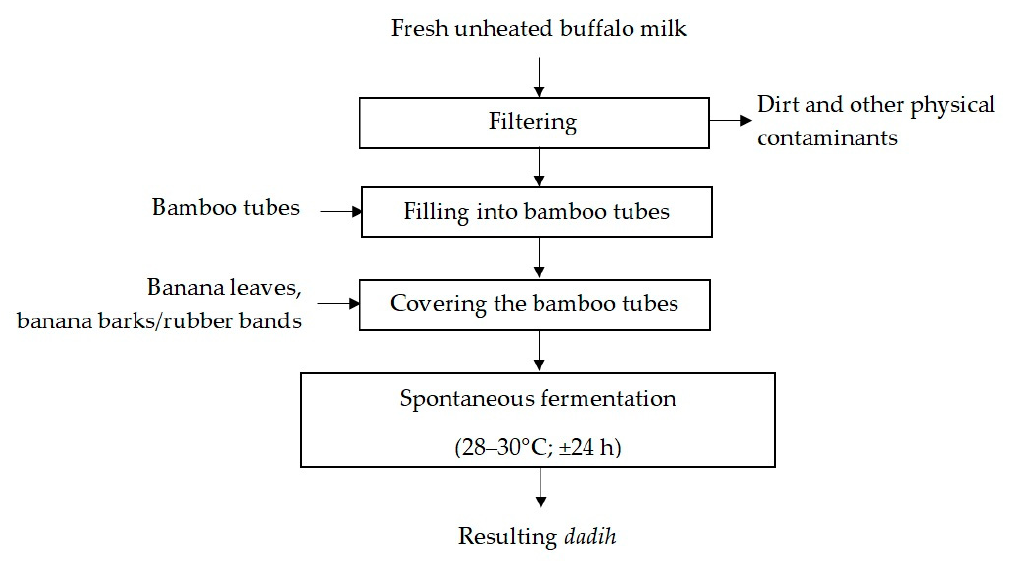
Figure 4. Traditional production process of dadih— fermented buffalo milk. Authors hold the copyright.